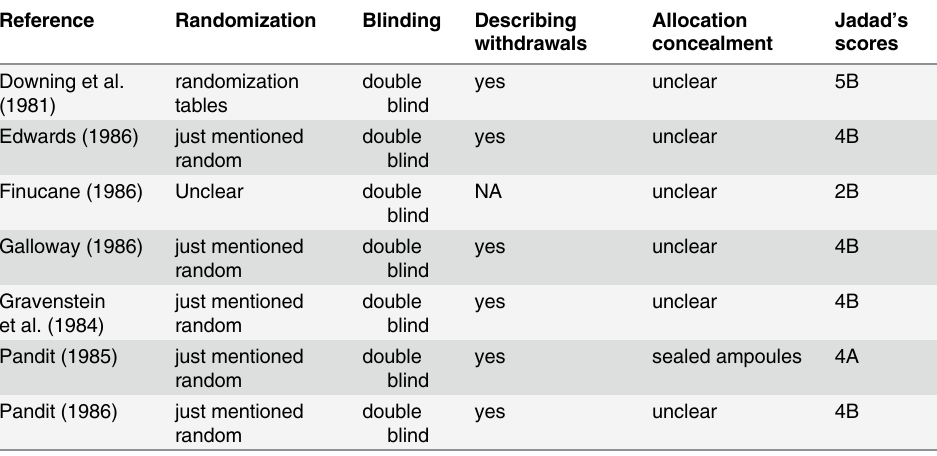
Table 2. Quality analysis of included